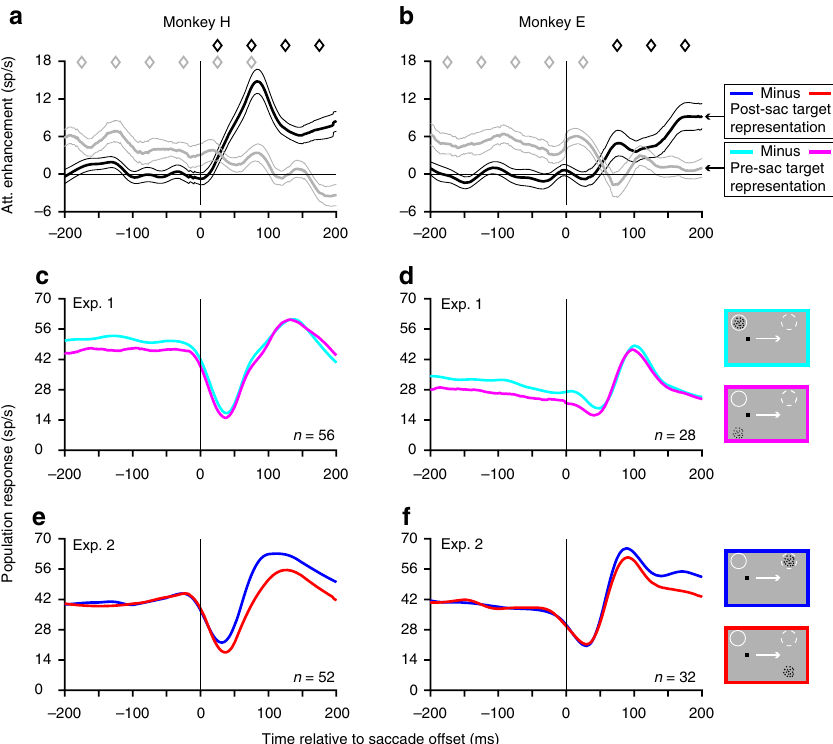
Fig. 2 The trans-saccadic attention shift is well synchronized to the saccade. a , b The attentional cross-over time (when the attentional enhancement of the post-saccadic target representation becomes larger than the attentional enhancement of the pre-saccadic target representation) occurs at 29 ms ( a , monkey H) and 53 ms ( b , monkey E) after saccade offset. Data are for monkey H in a and for monkey E in b . Gray and black curves show the mean difference (and s.e.m) between the target-in-RF and distractor-in-RF curves in Experiment 1 and Experiment 2, respectively (as shown in c – f ). Diamonds above the curves indicate the successive, non-overlapping 50 ms time-bins in which the differences are signi fi cantly larger than zero (one-sided t -test): black diamonds for the black curve and gray diamonds for the gray curve. c – f Same data as in Fig. 1b ( c , d ) and Fig. 1c ( e , f ), but plotted separately for the two monkeys and focusing on the time around the saccade ( − 200 to 200 ms relative to saccade offset); format otherwise identical. The gray curves in a and b are computed as the difference between the cyan and magenta curves in c and d , respectively, while the black curves in a and b are computed as the difference between the blue and red curves in e and f , respectively. Also see Supplementary Fig.